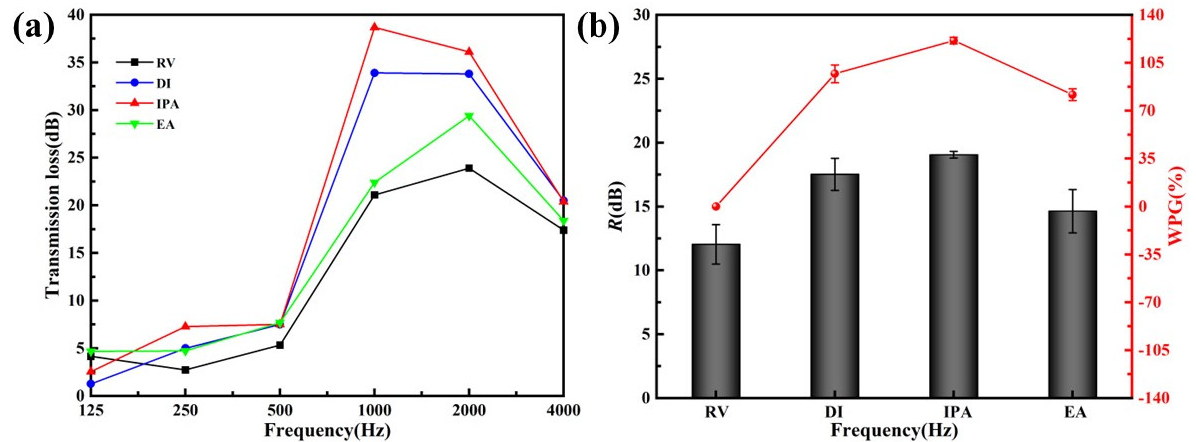
Figure 5. Sound insulation of unmodified veneer and FA-modified veneer with different solvents ( a ) transmission loss dependent on the frequency; ( b ) average sound insulation and WPG.